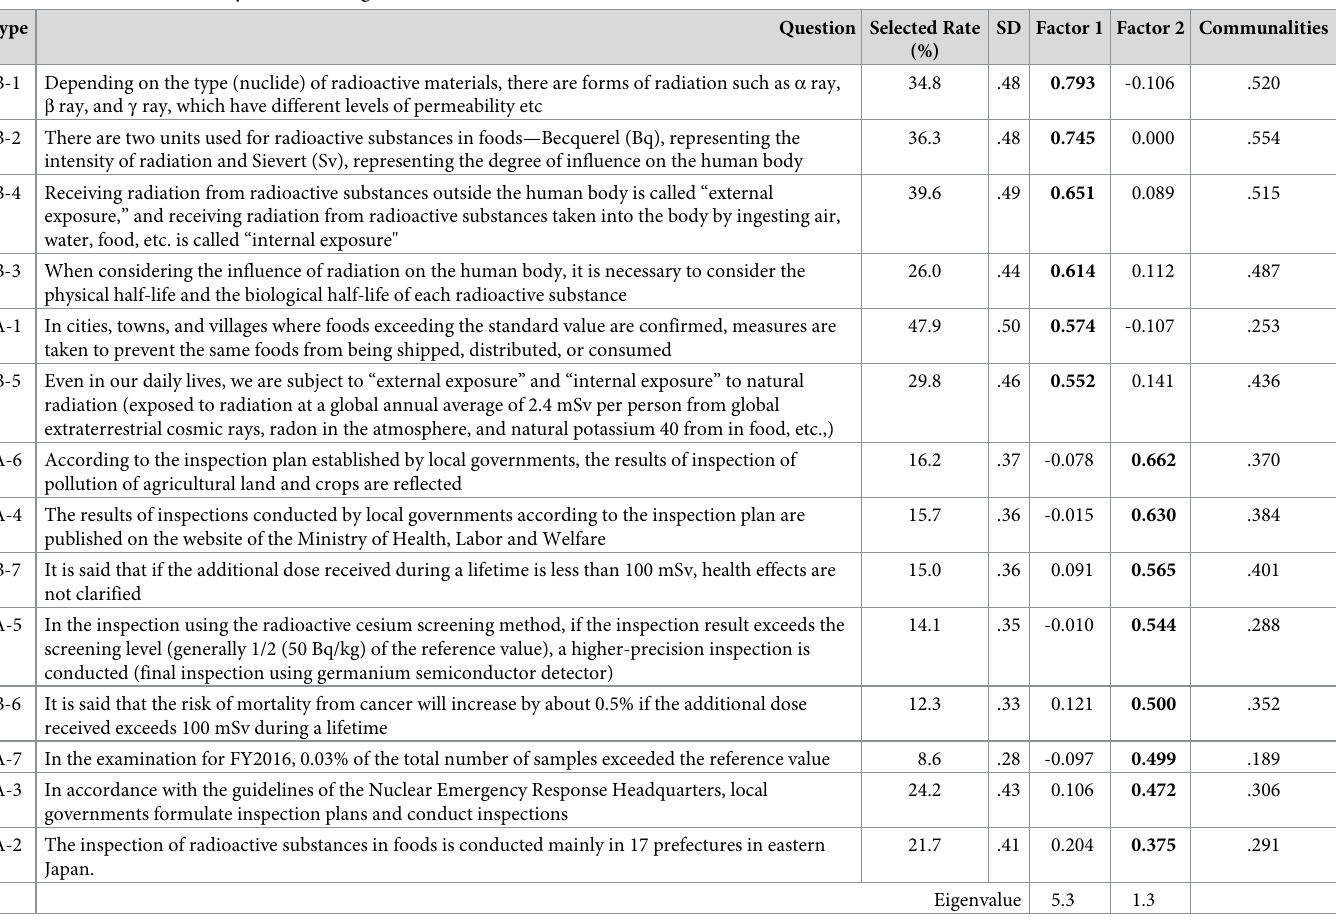
Table 3. Results of factor analysis of knowledge.